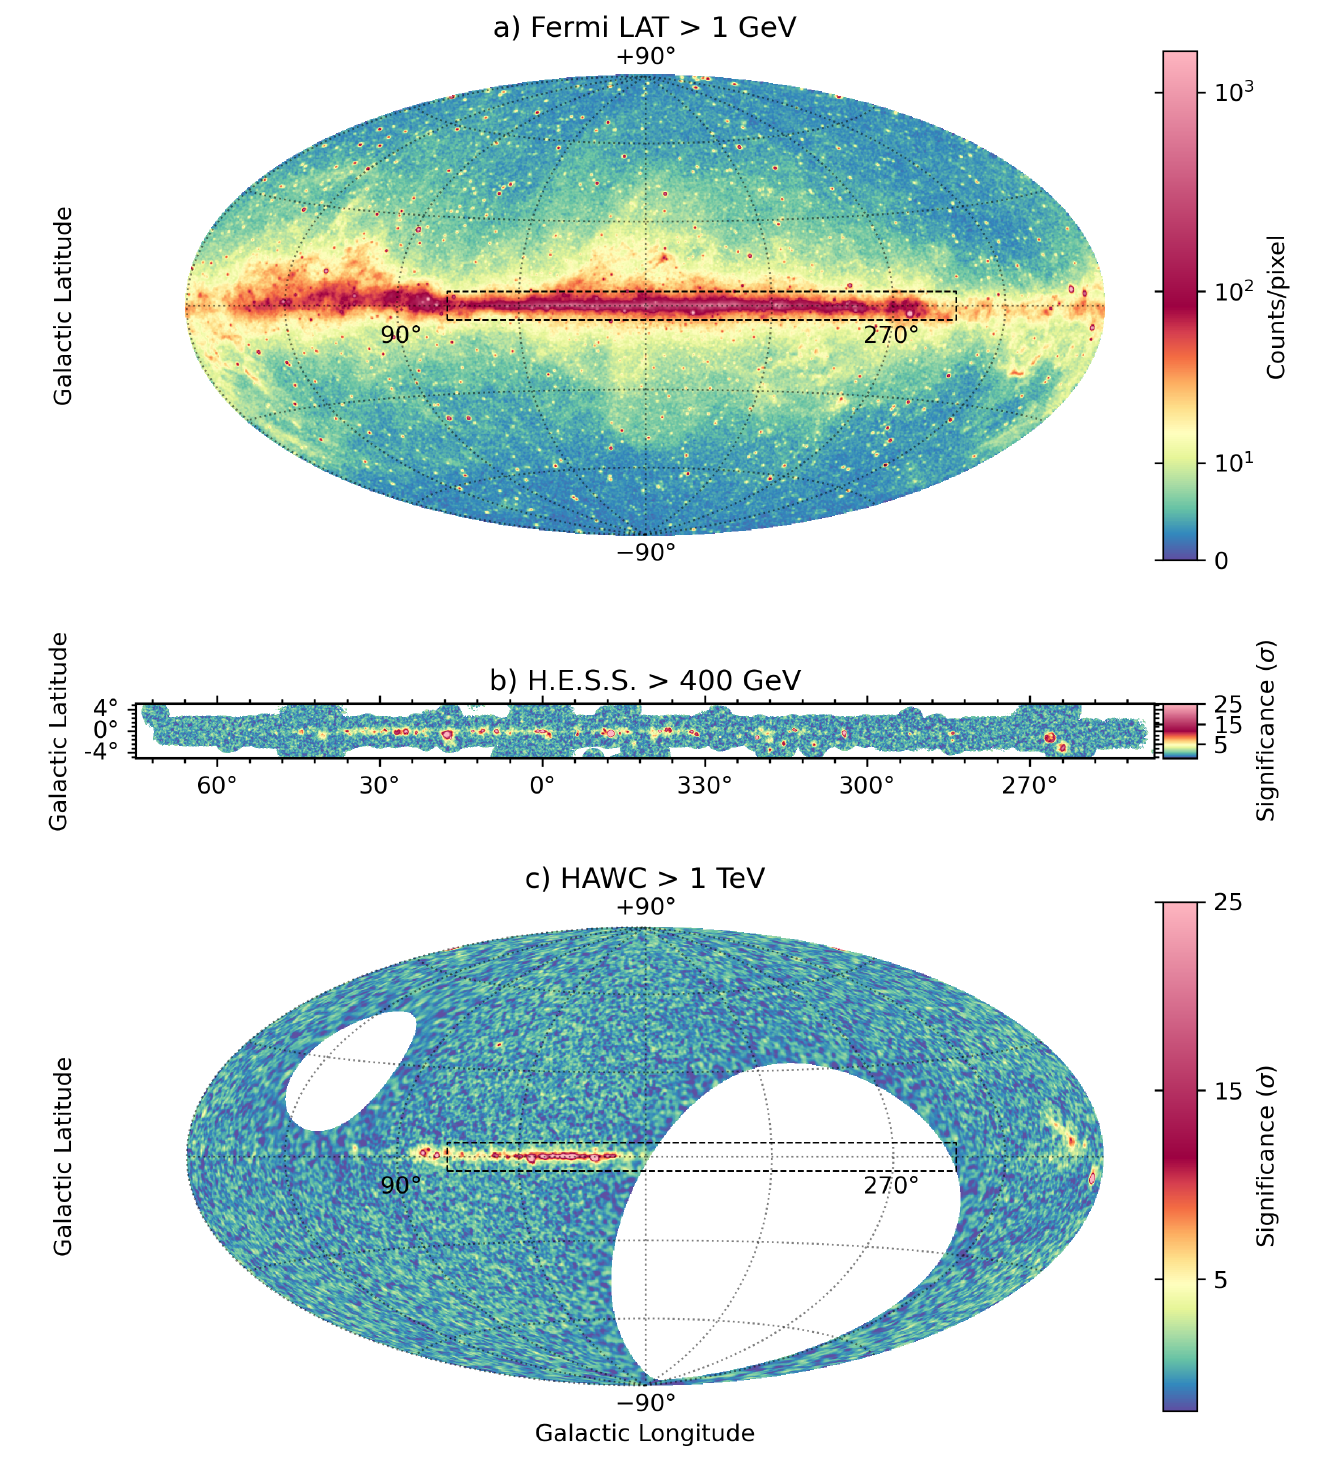
Figure 1. Images of the Milky Way from different instruments. ( a ) Fermi -LAT, 12 years of P8R3 data, energies > 1 GeV, Source /PSF3 event class/type, zenith angles <100 ◦ , smoothed with a Gaussian kernel of σ = 0.25 ◦ . ( b ) H.E.S.S. Galactic plane survey, map described in [40] (0.2 ◦ correlation radius). ( c ) HAWC survey, map construction described in [41] (test source with 0.5 ◦ extension and a power-law spectral index of 2.5). The footprint of map ( b ) is overlaid to the all-sky maps in ( a , c ) as a dashed rectangle. Map ( a ) displays observed counts not corrected for residual CR background, while maps ( b , c ) are given in units of significance of gamma-ray emission above the residual CR background. For maps ( b , c ) the actual energy threshold varies across the map and the figure provides a representative